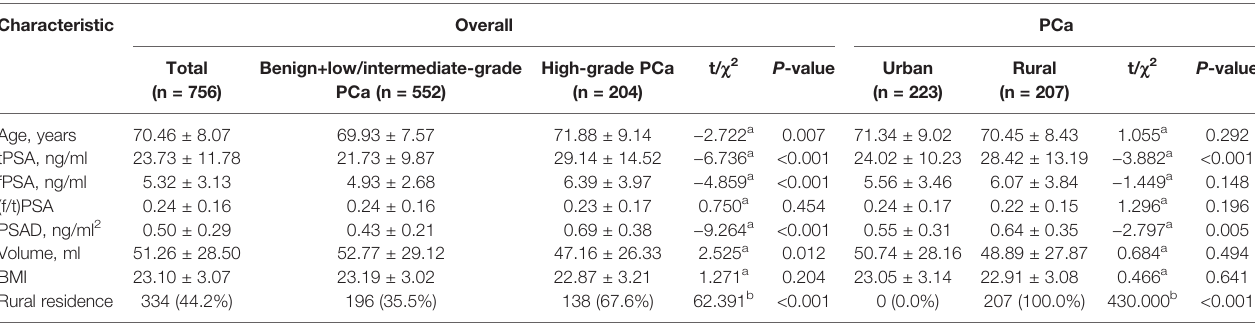
TABLE 1 | Clinical characteristics of study participants.